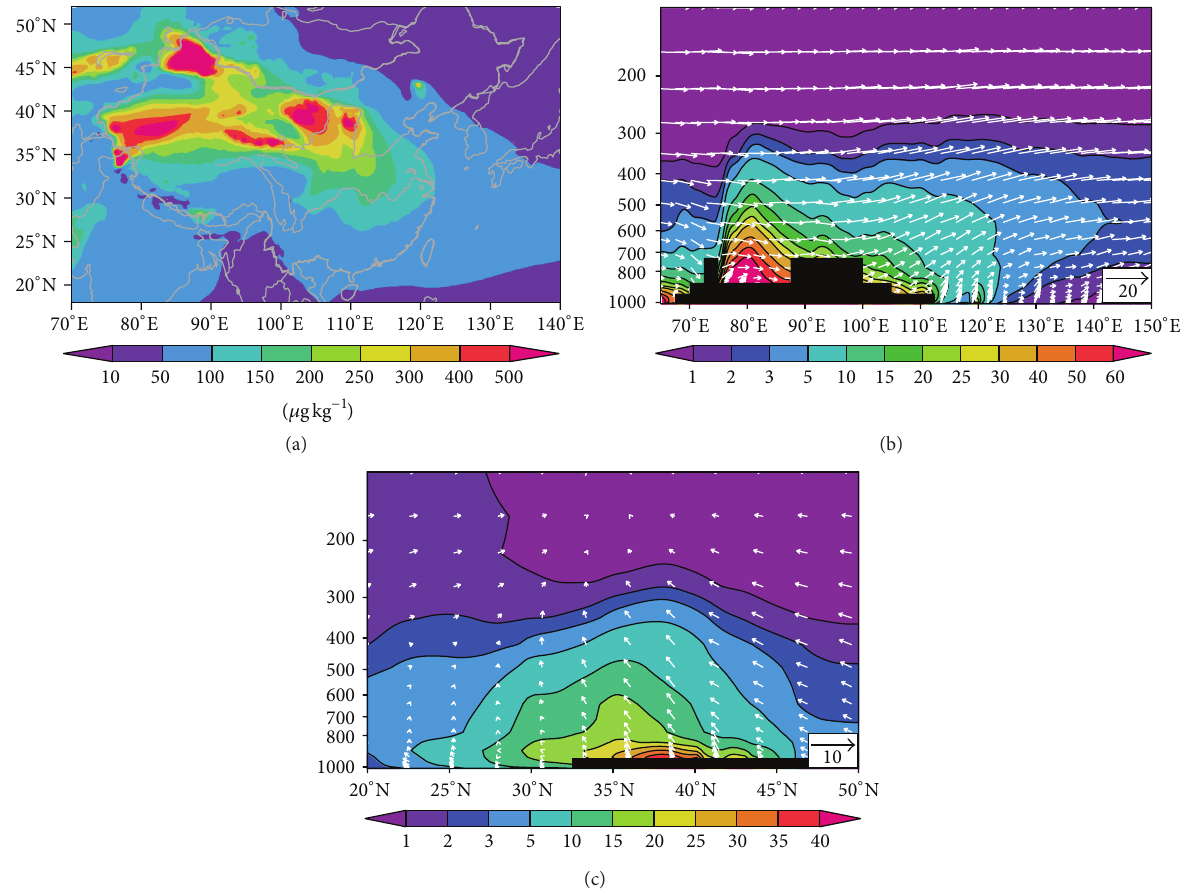
Figure 5: (a) The RegCM4 simulated dust mixing ratio horizontal distribution and (b) longitude-height cross section (averaged over 35– 50 ∘ N) and (c) latitude-height cross section (averaged over 105–120 ∘ E) for vertical wind field (Pas −1 , white vector) and the dust mixing ratio ( 𝜇 gkg −1 , color shaded) in winter during 2000–2009